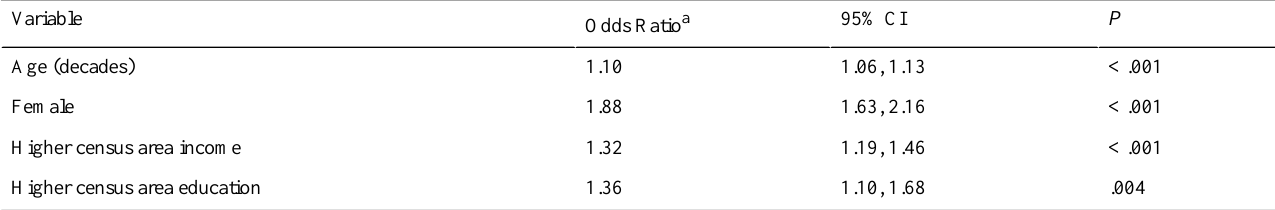
Table 4. Adjusted odds ratios for predicting enrollment of invitees by age, gender, and census area income and education